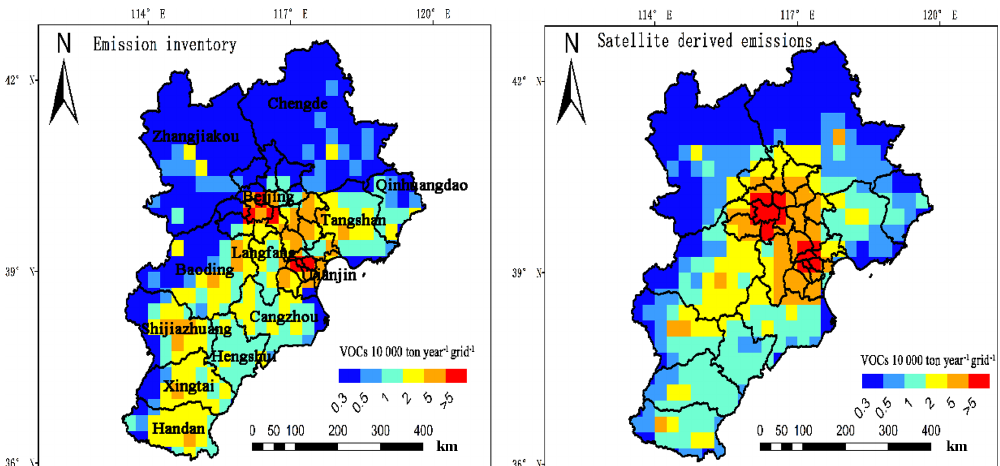
Figure 11. Comparison between spatial distribution of VOC emissions obtained from the EF-derived emission inventory and the satellite- derived emission inventory with a 0.25 ◦ × 0.25 ◦ spatial resolution.